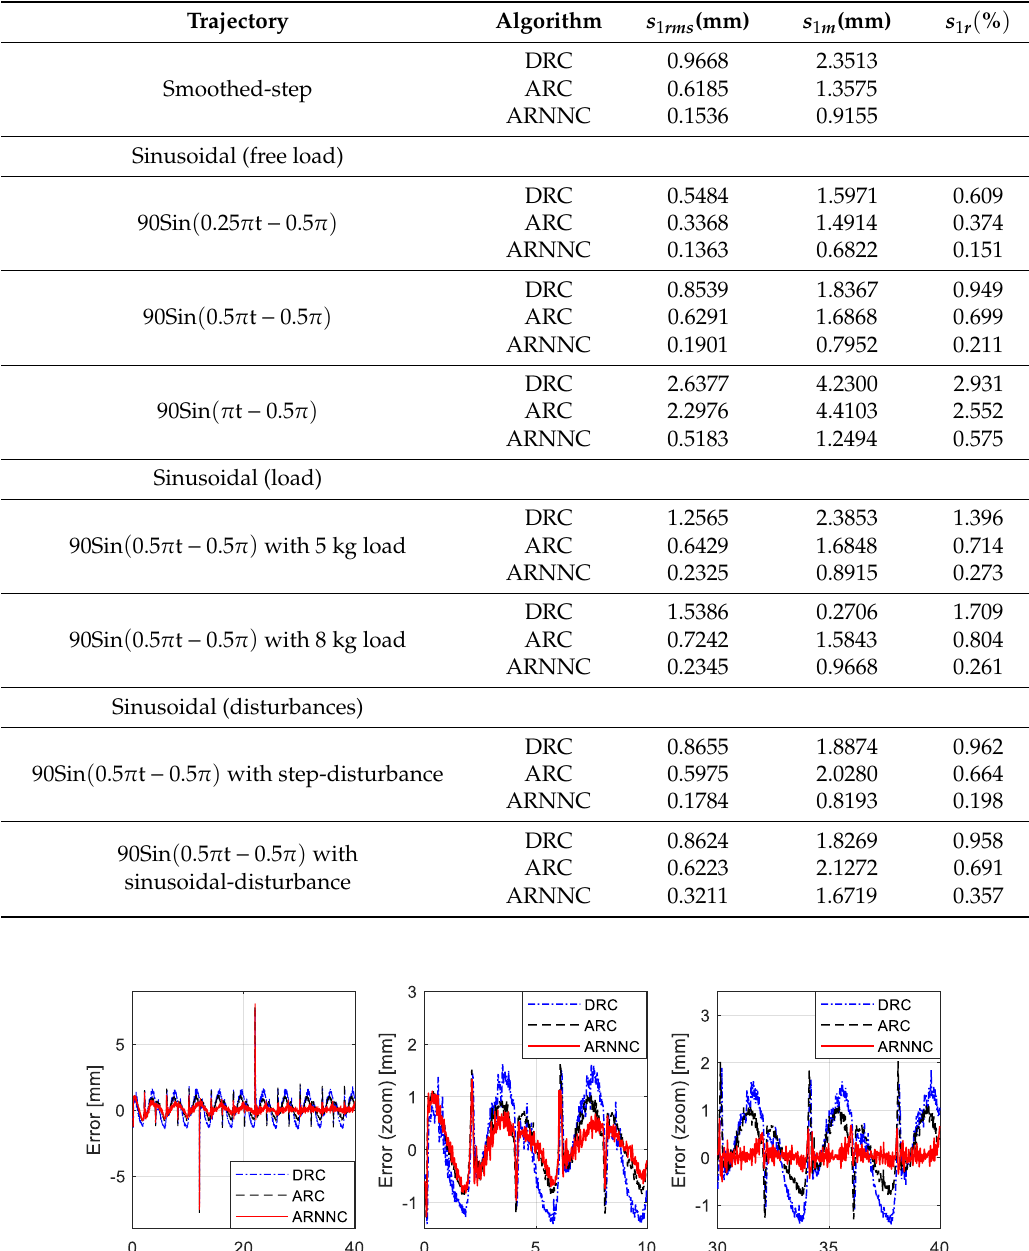
Table 3. Performances of comparative experiments.